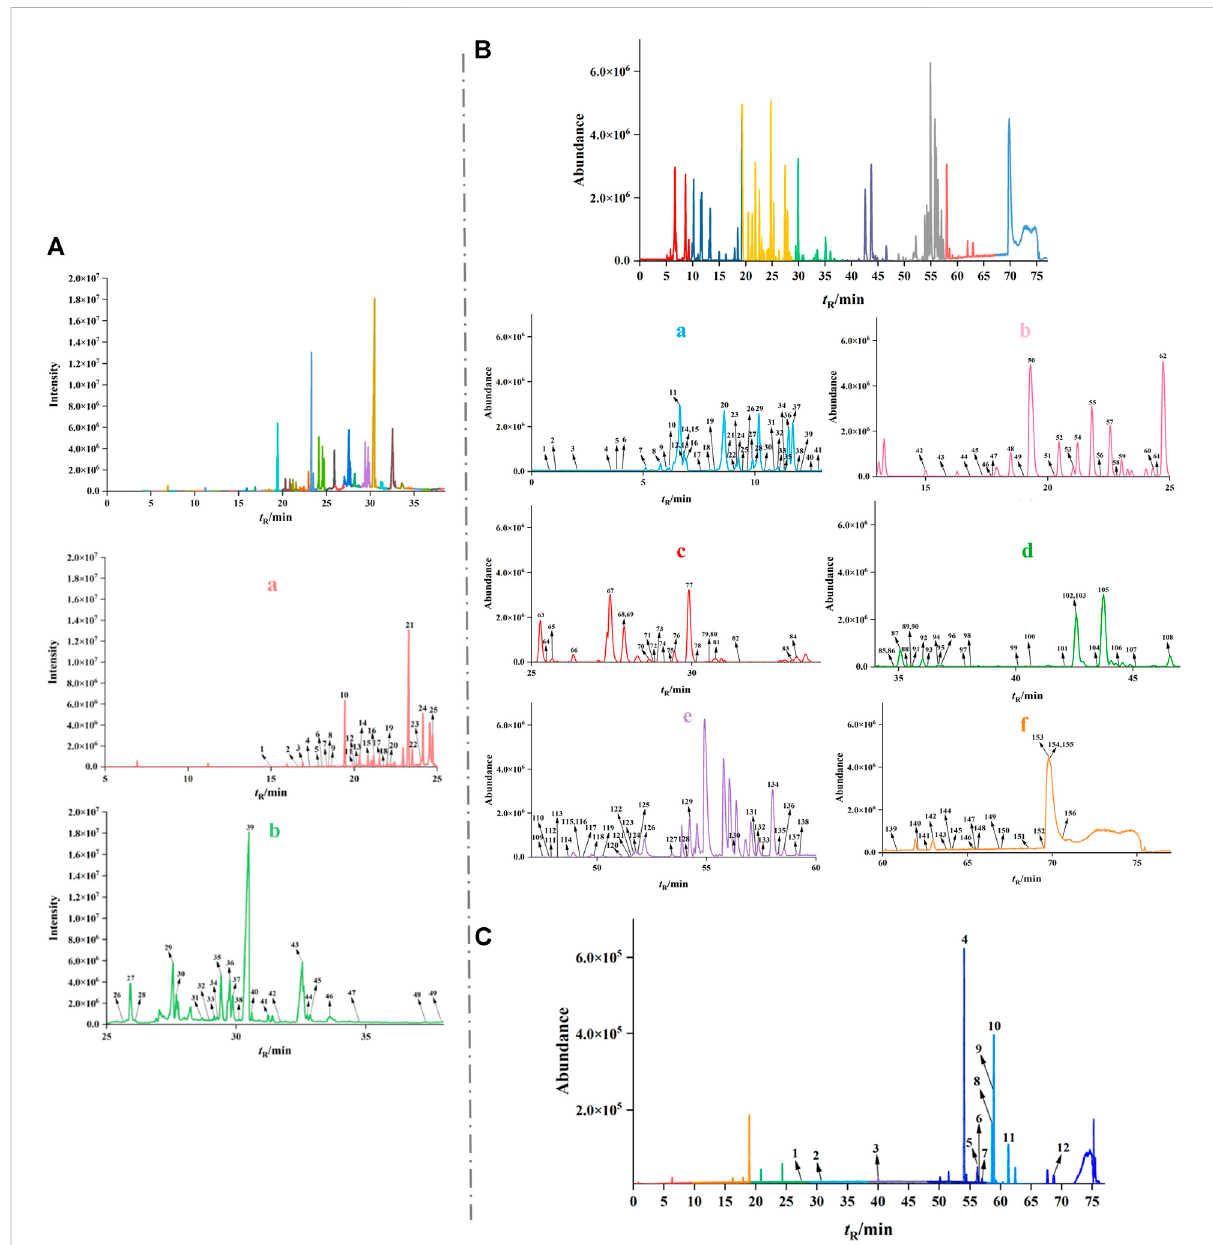
FIGURE 1 The total ion chromatograms (TICs) of WPW by GS-MS and UPLC-Q-TOF/MS. (A) TIC of WPW by GS-MS (a. 5 – 25 min GC-MS total ion fl ow diagram b. 25 – 38 min). (B) TIC of WPW in positive ion mode (a. 0 – 13 min total ion fl ow diagram, b. 13 – 25 min, c. 25 – 34 min, d. 34 – 47 min, e. 47 – 60 min, f. 60 – 77min). (C) TIC of WPW in negative ion